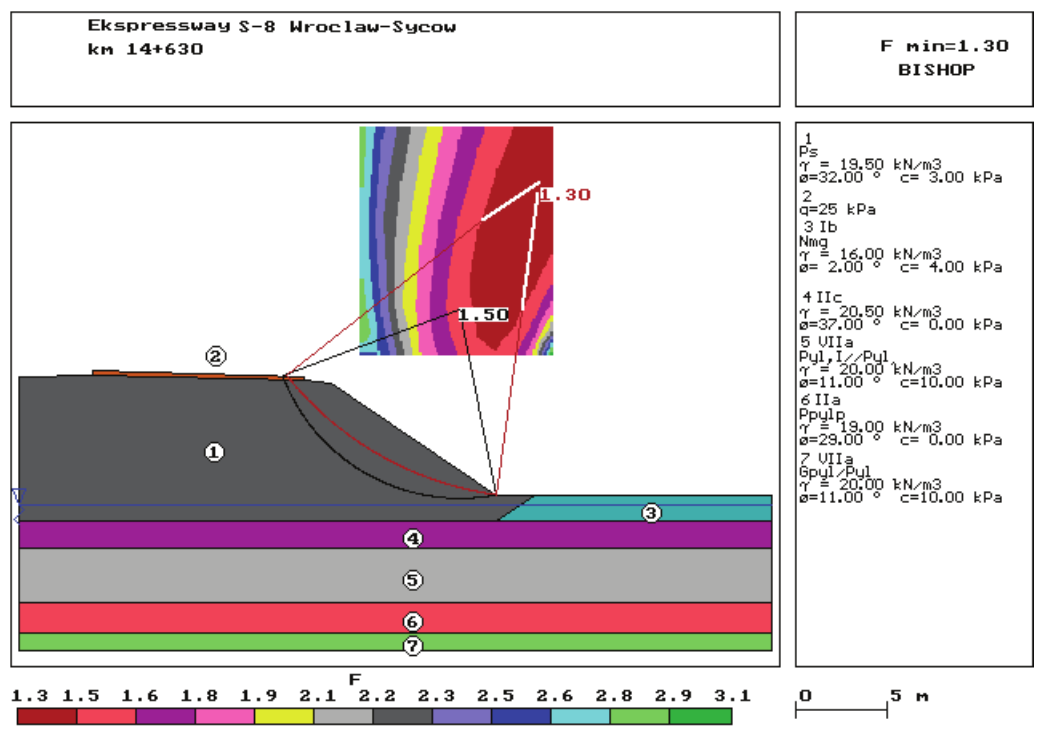
Figure 3b: Expressway S-8 Wrocław-Syców, cross-section at km 14+630 -replacement of the layer of